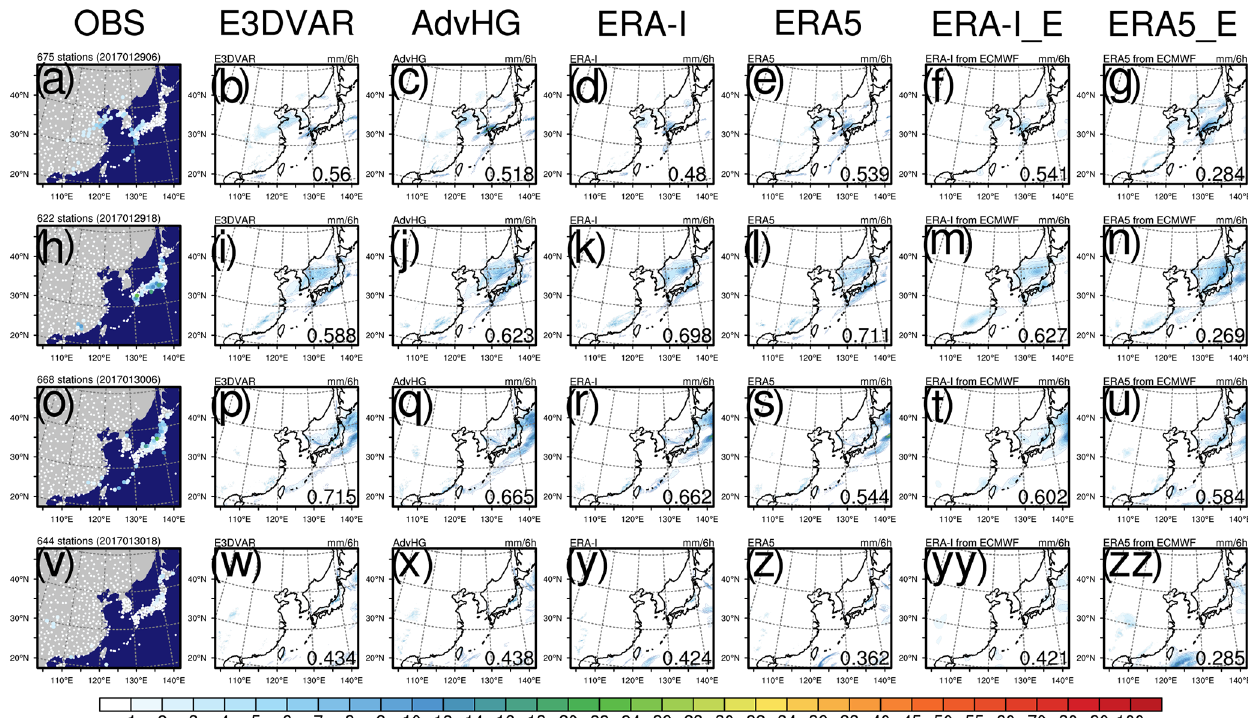
Figure 11. The spatial distribution of 6h accumulated precipitation of (1st column) observation, (2nd column) E3DVAR, (3rd column) AdvHG, (4th column) ERA-I, (5th column) ERA5, (6th column) ERA-I_fromECMWF, and (7th column) ERA5_fromECMWF and the pattern correlation coefficient (PCC) shown at the bottom right of each figure at the valid time (1st row, 3rd row) of 06:00UTC and (2nd row, 4th row) 18:00UTC on 29 and 30 January